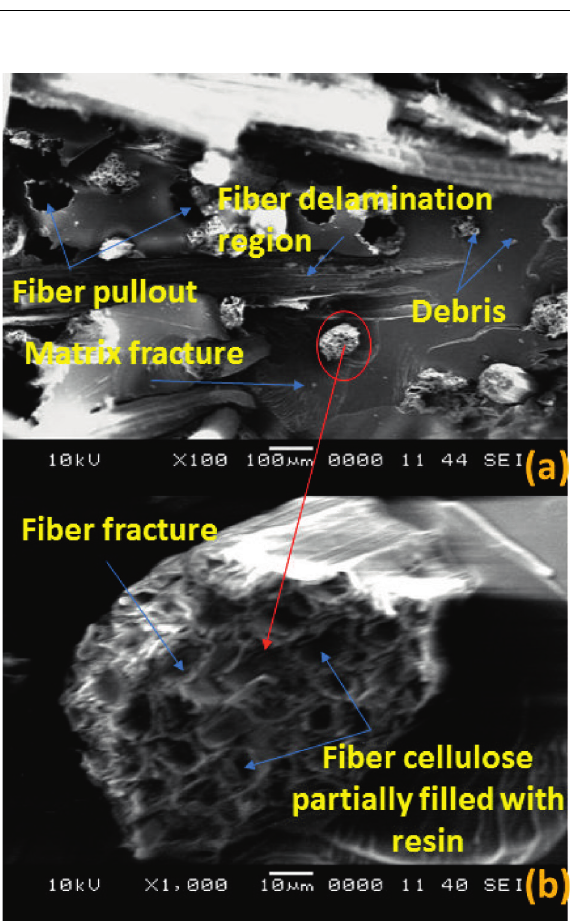
Figure 11: (a, b) Tensile fractured surface morphology of sample